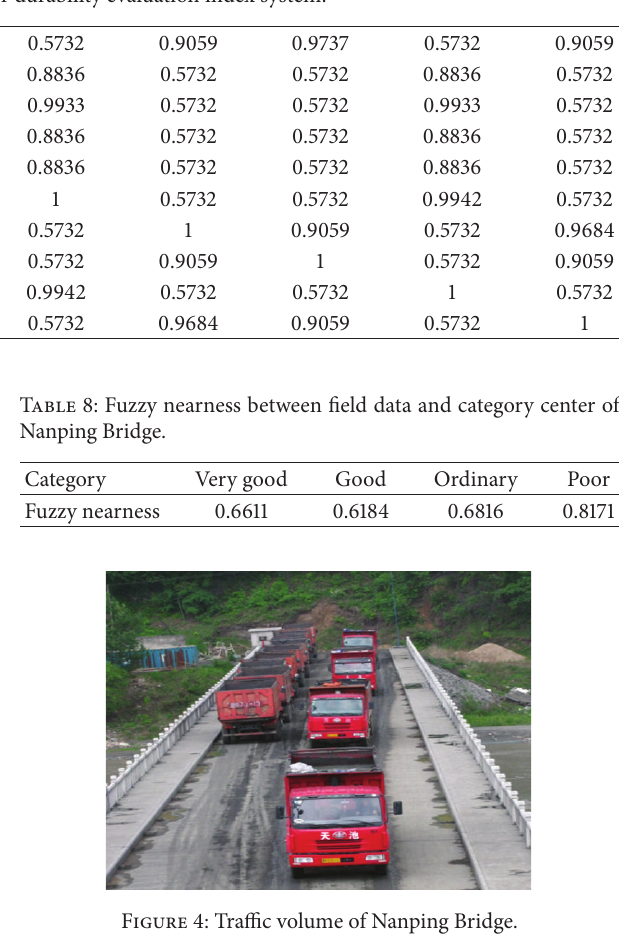
Table 2: Fuzzy equivalence matrix for durability evaluation index system.